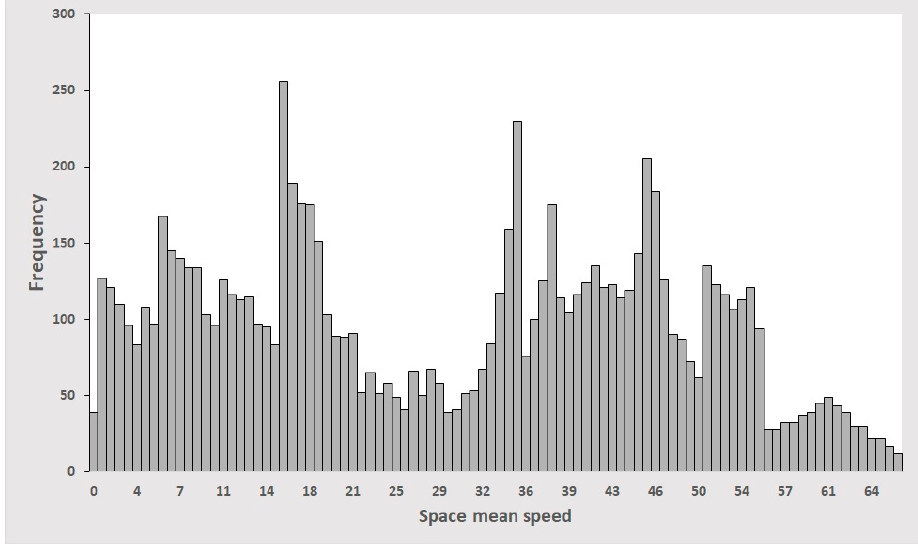
Figure 7. Distribution of space mean speeds for 9000 pairs of animation images.